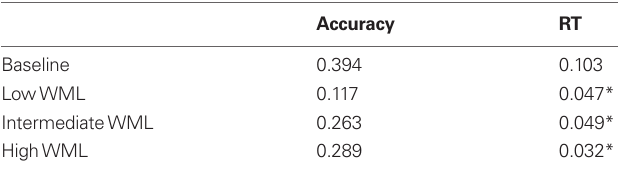
Table 5 | p values for Time 1 versus Time 2 behavioral data for the TBI